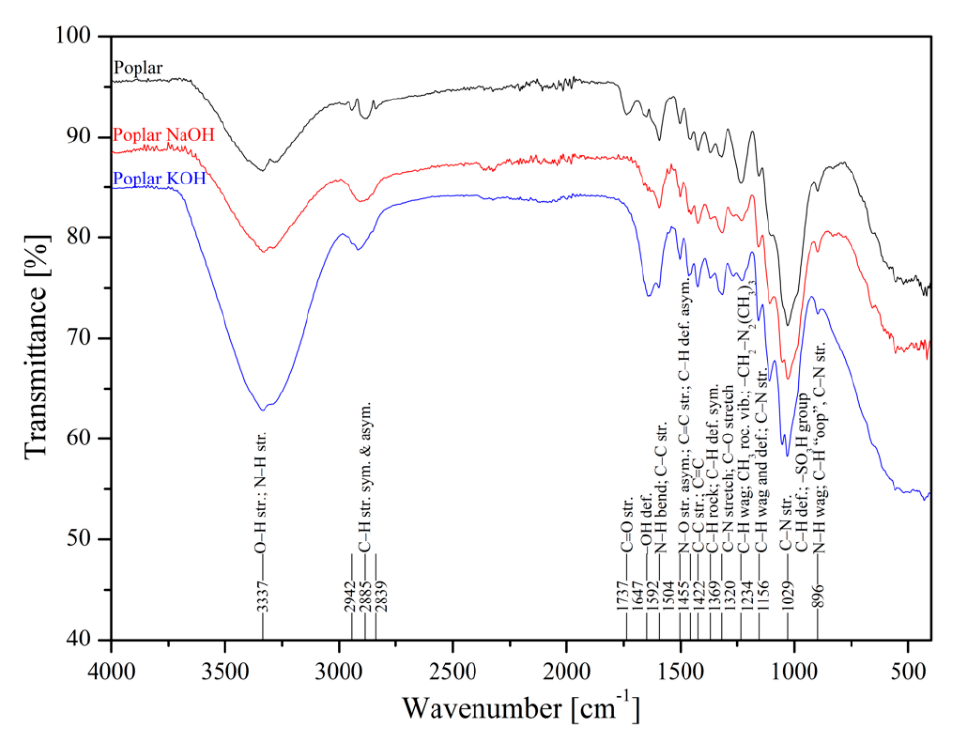
Figure 2. Infrared spectra of natural and treated cherry sawdusts. 3.2. Removal Efficiency The initial concentrations of heavy metals have a significant effect on the adsorption capacity of sawdust, as a certain mass of the sawdust can sorb only a certain amount of the contaminant. The higher the concentration of the copper in the solution, the less able the sawdust is to eliminate it from the solution. At higher concentrations of pollutants, the fractional adsorption is low [72]. To determine the adsorption capacity of natural and modified sawdust, sorption experiments were performed with different initial concentrations (10, 30, 50, 70, 90, 110, 130, and 150 mg/L) of copper ions at the initial value of pH = 4.0. Sciban et al. [73] noted that sawdust leaches some organic materials into water during the process of biosorption. Demcak [50] confirmed that alkali-modified sawdust reduced the release of organic matter into the synthetic solutions.